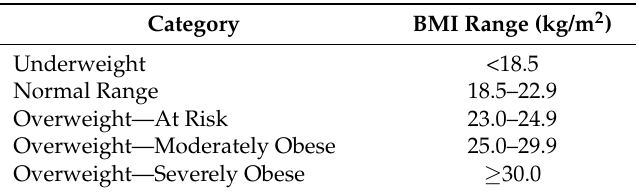
Table 1. BMI categories for